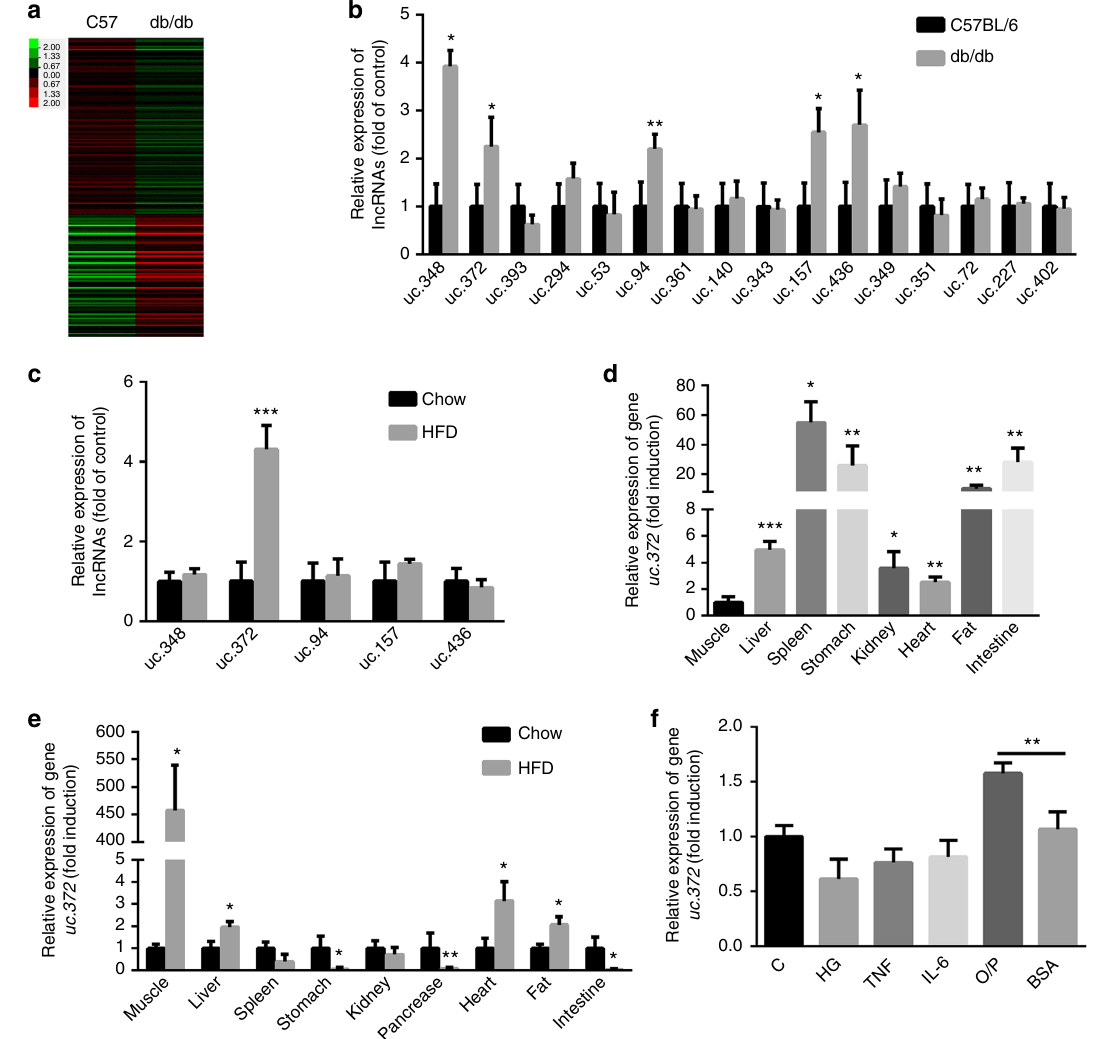
Fig. 1 Identi fi cation of uc.372 upregulated in the livers of db/db mice and HFD-fed mice. a LncRNA-wide expression pro fi ling in the liver of 8-week-old male db/db mice ( n = 5). b Expression levels of ucRNAs in the liver of 8-week-old male db/db mice analyzed by real-time PCR ( n = 5). c Expression levels of ucRNAs in the liver of 10-week-HFD-fed mice analyzed by real-time PCR ( n = 5). d Distribution of uc.372 in various tissues of 6- to 8-week-old C57BL/6J mice ( n = 3). e Distribution of uc.372 in various tissues of 10-week-HFD-fed mice ( n = 5). f Expression level of uc.372 in HepG2 cells treated with 33.3 mM high glucose (HG), 20 nM tumor necrosis factor (TNF), 20 nM IL-6, or 300 μ M O/P mixture ( n = 3). Data are mean ± SEM; * P < 0.05; ** P < 0.01; *** P < 0.001 vs. control group. ( b , c , e Student ’ s t -test; d , f analysis of variance